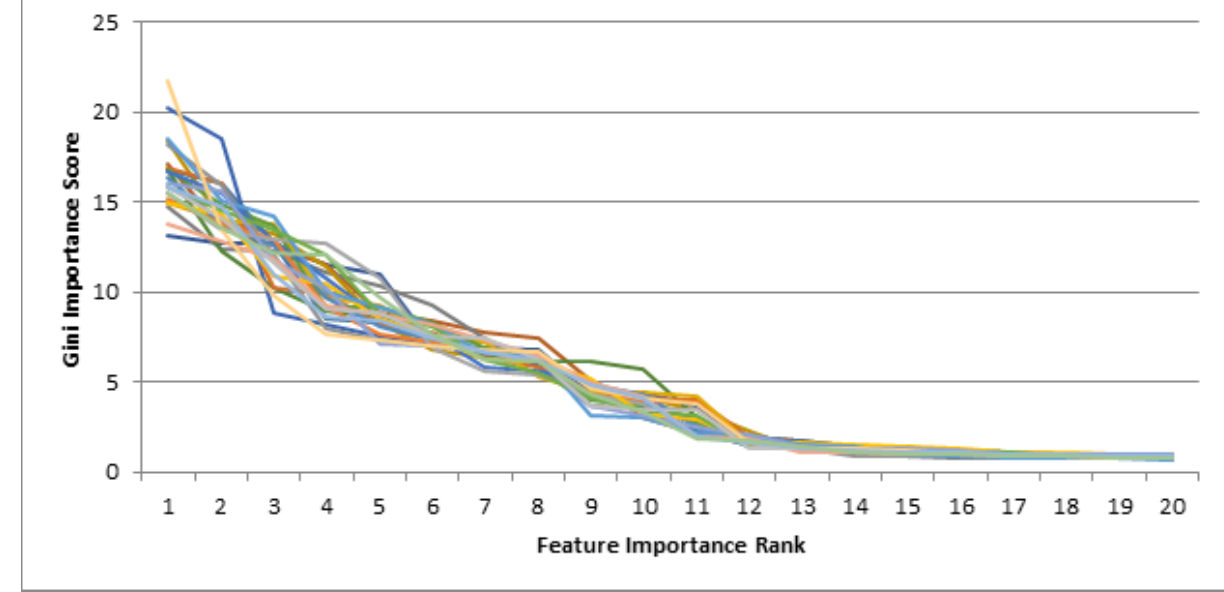
Figure 3. Ranking of importance of features according to Gini importance criterion for all 25 different training